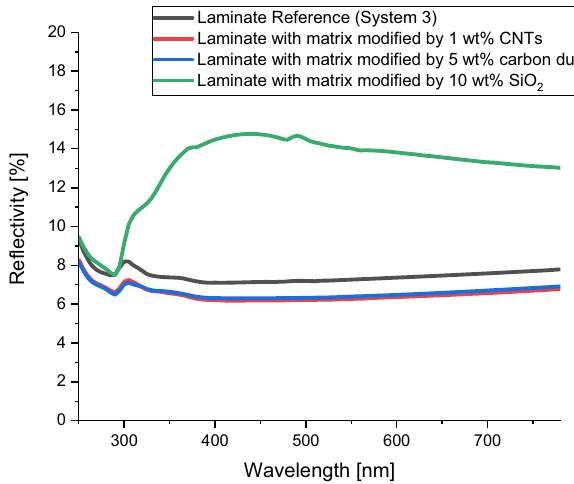
Figure 6: Re fl ectivity of carbon fi ber composite laminates with modi fi ed matrix ( system 3 ) using CNTs, carbon dust, and SiO 2 nanoparticles compared to unmodi fi ed composite laminates.